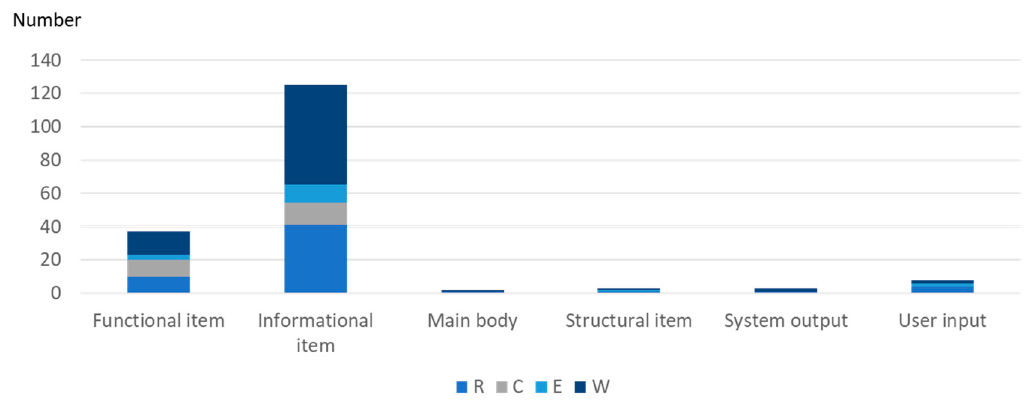
Figure 3. Depiction of the number of user interface elements by provisions and guidelines.